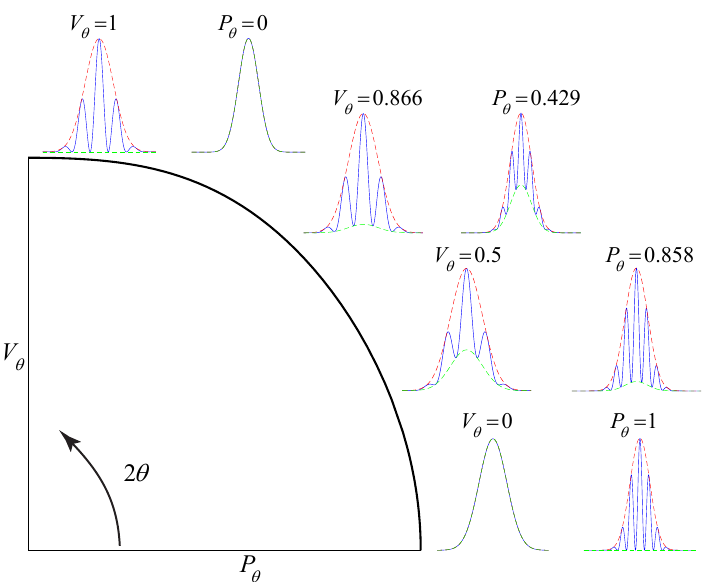
Figure 2. One-particle visibility V θ (11) and two-particle visibility (predictability) P θ (17) computed from the corresponding quantum probability distributions f p different strengths of entanglement controlled by θ = 0, π /12, π /6 and π /4. This plot illustrates the smooth transition from zero visibility and maximal predictability, to maximal visibility and zero predictability, as the entanglement diminishes. The bold line depicts a polar curve of P 2